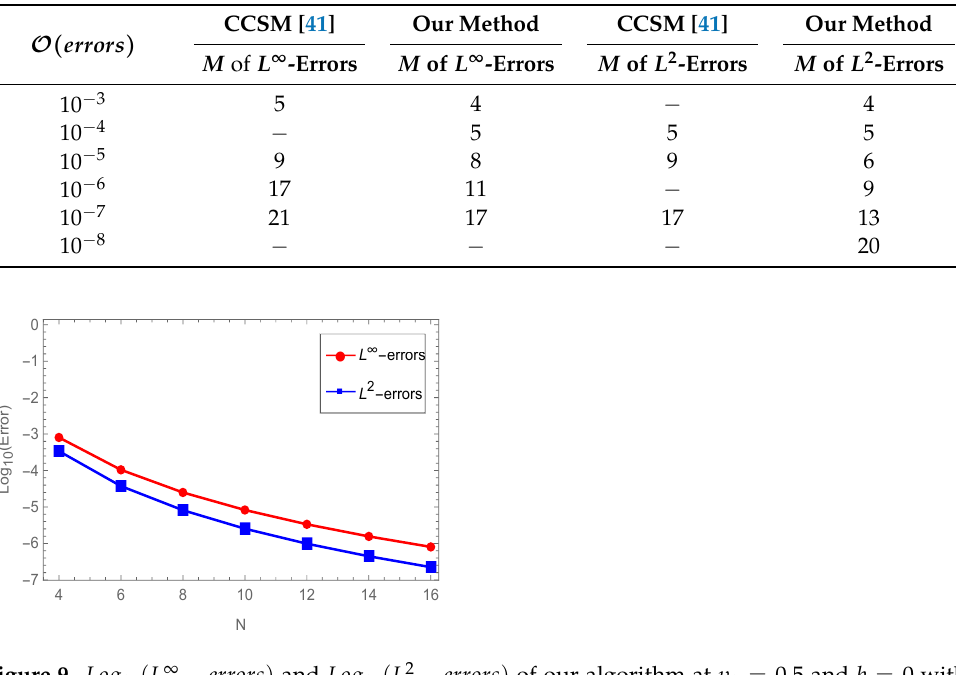
Figure 9. Log 10 ( L ∞ − errors ) and Log 10 ( L 2 − errors ) of our algorithm at υ 1 = 0.5 and b = 0 with distinct N for Example